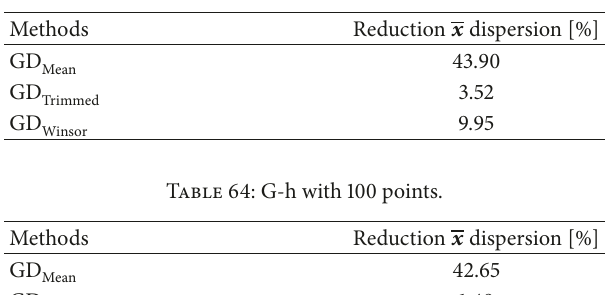
Table 63: G-h with 50 points.